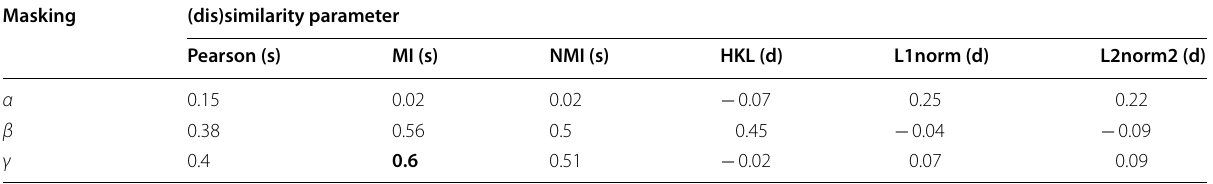
MI mutual information, NMI normalised mutual information, HKL Kullback–Leibler divergence, L1Norm L 1 norm or Manhattan norm, L2norm2 square L 2 norm or square Euclidean distance, (s) similarity parameter, (d) dissimilarity parameter (data are rounded to two significant digits, the highest correlation coefficient is emphasized in